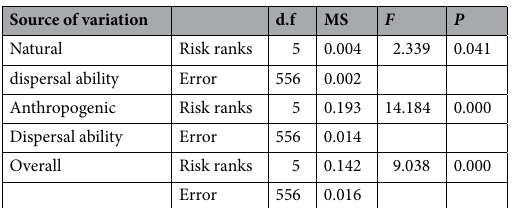
Table 2. ANOVA results for the natural, anthropogenic, and overall natural and anthropogenic dispersal abilities of alien plant species in the six risk